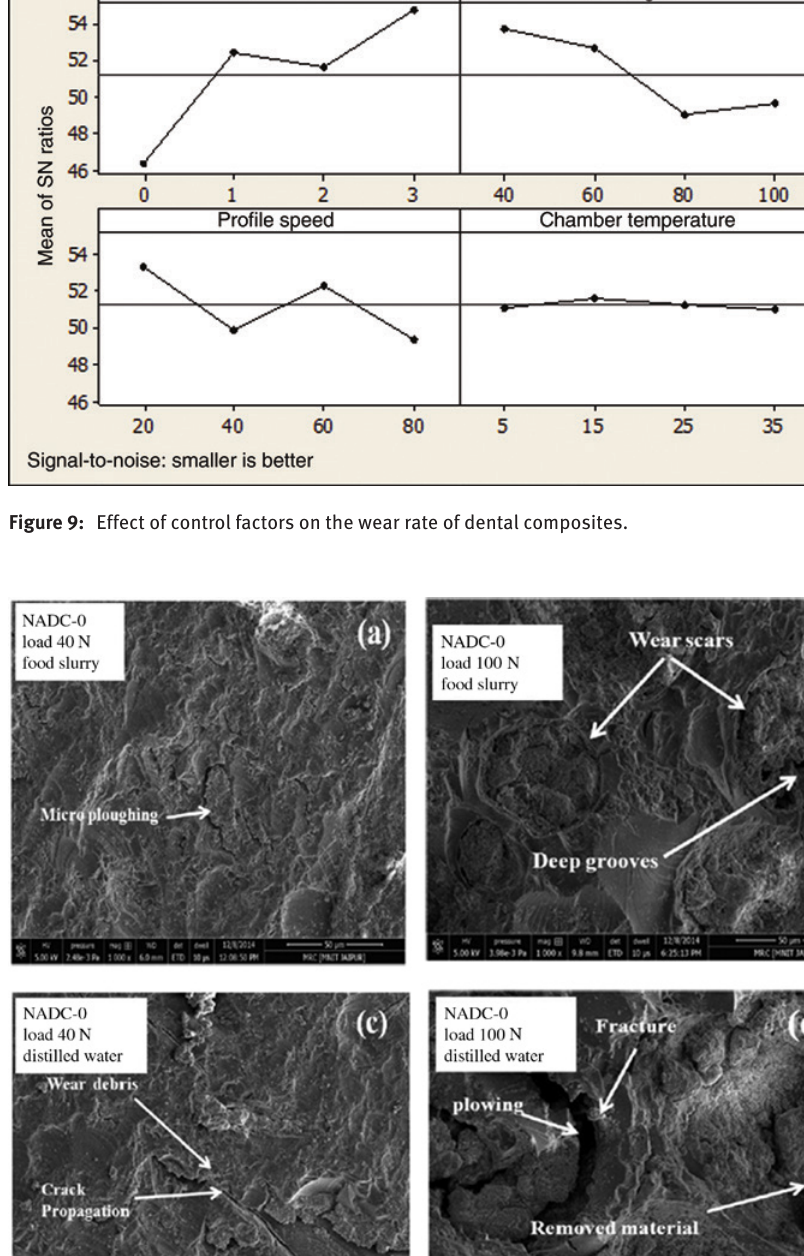
water condition. A micrograph for unfilled dental com- posite under 40 N normal load is shown in Figure 10a. Here microploughing can be seen due to